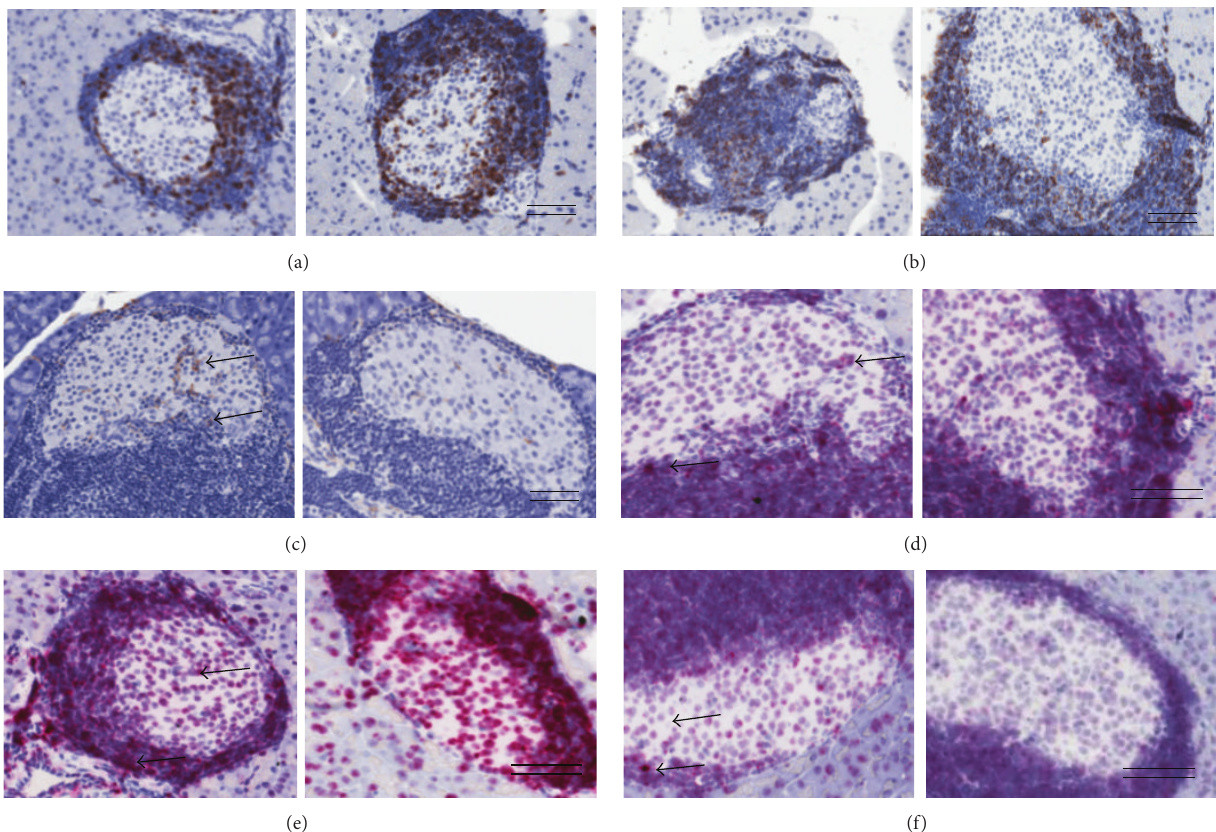
Figure 5: Immune cell distribution and expression of proinflammatory cytokines in NOD mice pancreata. Immunohistochemistry staining of the immune cells in pancreatic islets of vehicle (left) and SER140 treated (right) mice at day 56 of treatment, for (a) CD3, (b) CD20, and (c) F4/80. Arrows indicate F4/80 + cells. In situ hybridization analysis of the expression of genes encoding the proinflammatory cytokines IL-6 (d), TNF- 𝛼 (e), and IFN- 𝛾 (f) in and around pancreatic islets (red dots, arrows) in vehicle versus SER140 treated mice at day 56 of treatment ((d)–(f)). ((a)–(f)) Left: vehicle, right: SER140 treated. Scale bars = 100 𝜇